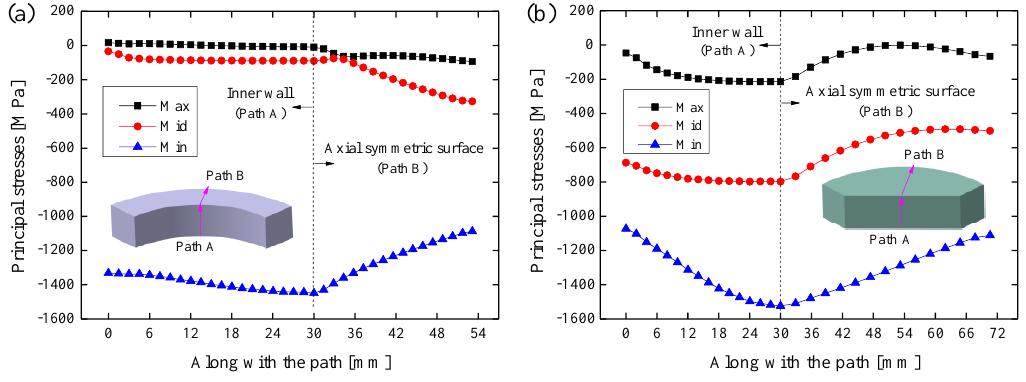
Figure 7. Principal stress distributions of first layer supporting rings: ( a ) BTD; and ( b ) DLSD.